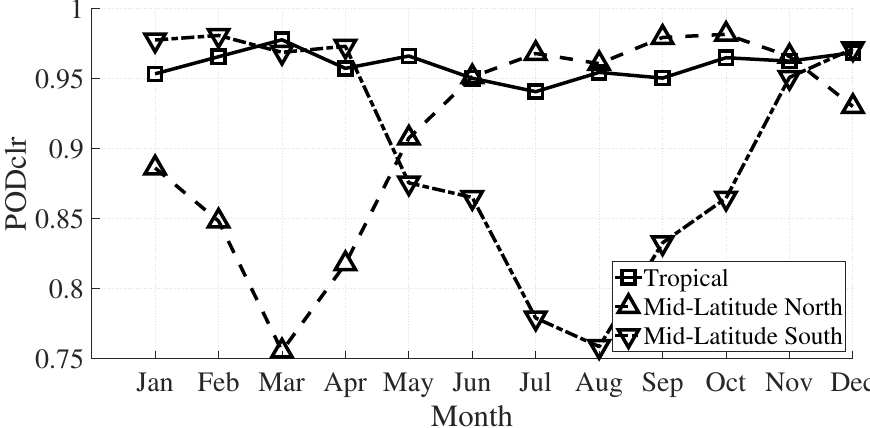
Figure 6. POD clr in function of the month for tropical and midlatitude. The lower POD for clear-sky pixels during winter-spring months causes a monthly variation of the KSS and FB s. Table 6. Seasonal variation of the obtained skills scores when comparing the SWCM against the RCM. Tropical